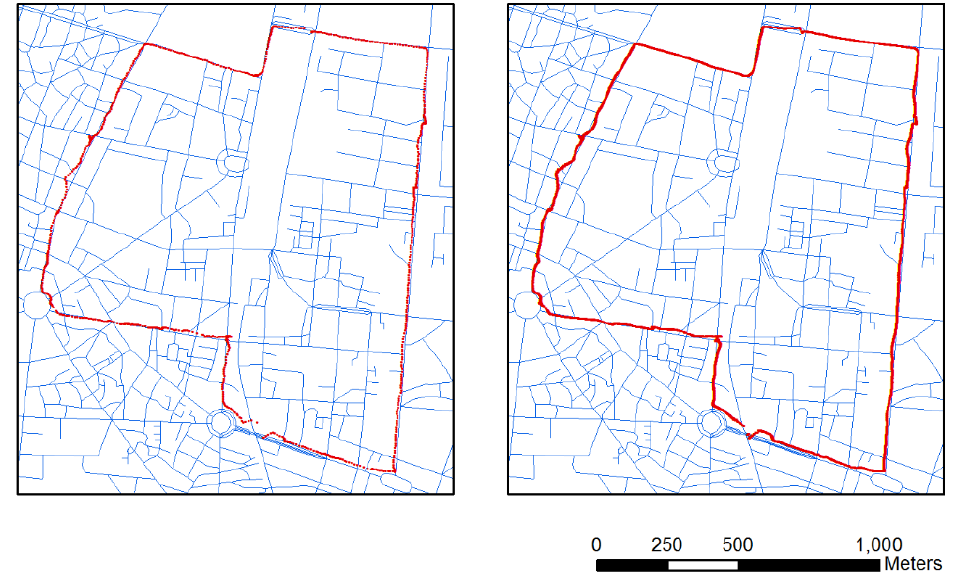
Figure 4. Raw GPS ( Left ) and integrated GPS/INS point data by KF ( Right ).